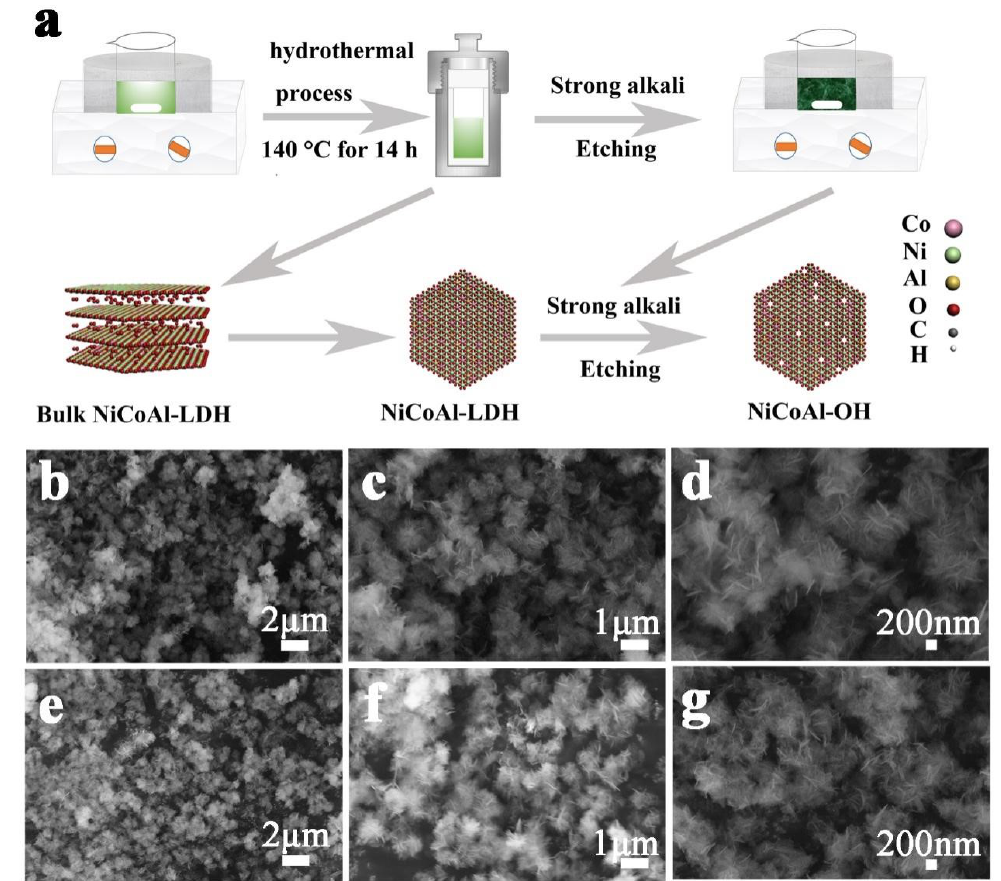
Figure 1. ( a ) The illustration of the preparation process and structures of NiCoAl-LDH and NiCoAl- OH. ( b – d ) SEM images of NiCoAl-LDH. ( e – g ) SEM images of